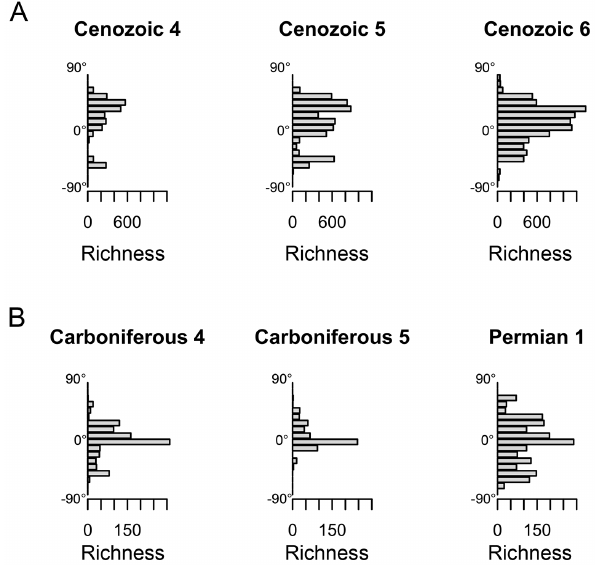
Figure 4. The distribution of genus richness across latitudes plotted for key intervals. A) For the last three Cenozoic time intervals (Cenozoic 4–6), Cenozoic 6 has more equitable sampling across latitudes than its predecessors. B) The Permo-Carboniferous boundary reflects a weakness in geographic coverage that biases estimates of global diversity inferred by